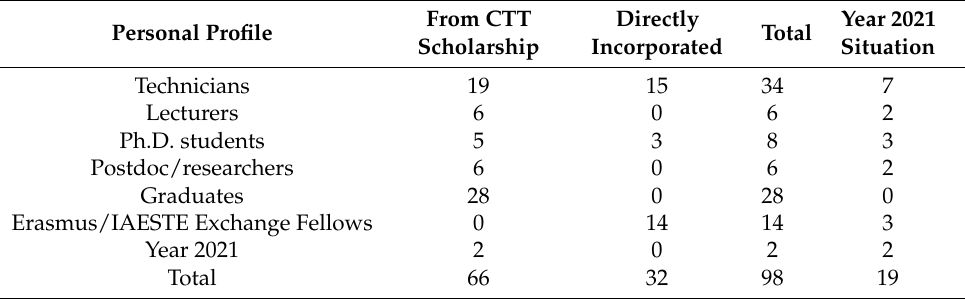
Table 10. Year 2021. Types of hiring of SARTI staff.